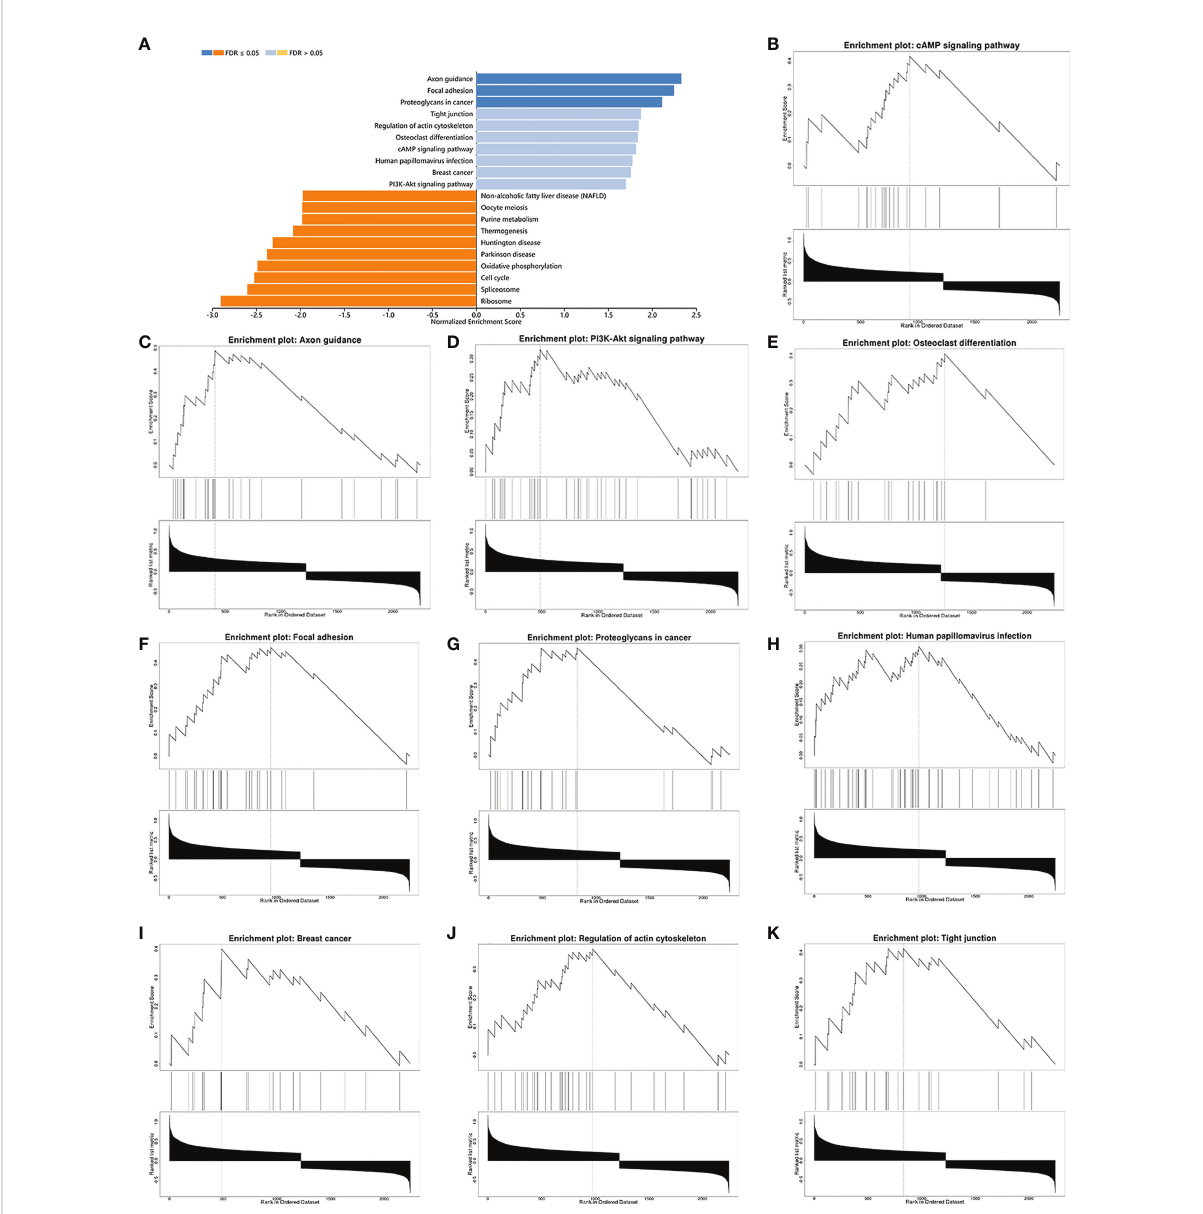
FIGURE 5 GSEA enrichment analysis of differential genes in high and low RARG expression groups. (A) Histogram of GSEA enrichment of differentially expressed genes in high and low RARG expression groups. (B – K) The top 10 biological pathways positively correlated with high RARG